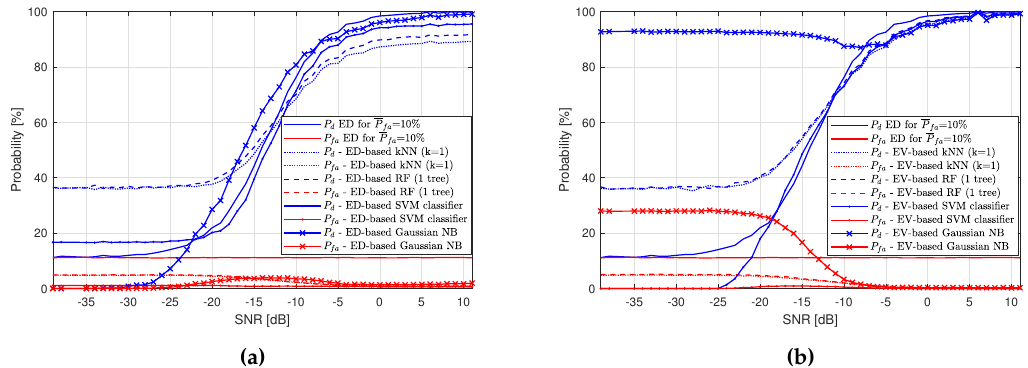
Figure 19. Probabilities P d and P fa in different locations for the applied k-Nearest Neighbors, Random Forest, Gaussian Naive Bayes and Support Vector Machine classifier methods. ( a ) P d and P fa surfaces for Energy Detection-based Machine Learning algorithms; ( b ) P d and P fa surfaces for Energy Vector-based Machine Learning